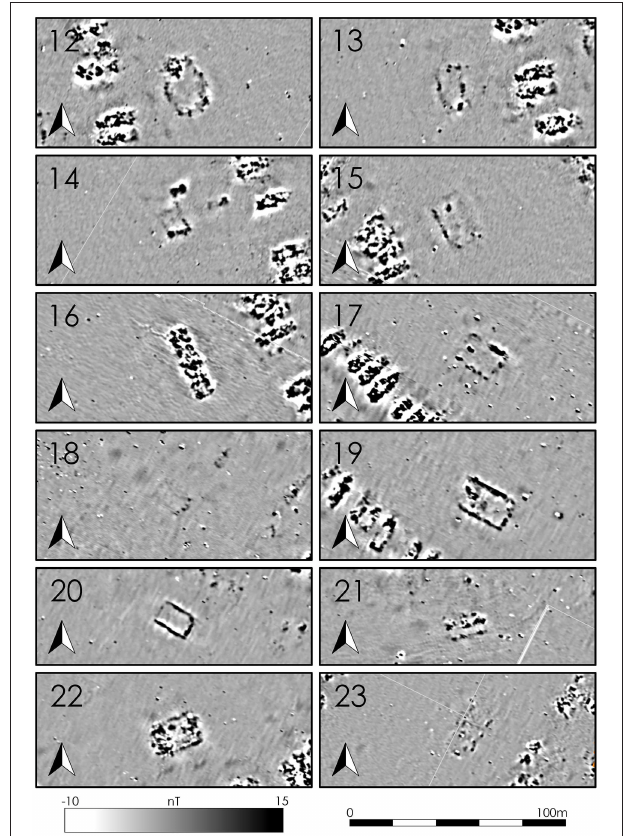
FIGURE 12 | Geophysical plots of Assembly Houses (larger structures in each plot) and adjacent dwelling houses, Nebelivka, selected to show the variability of this form of structure: 12–14: Quarter H; 15–16: Quarter I; 17–18: Quarter J; 19–20: Quarter K; 21–22: Quarter L; 23: Quarter M. Numbers of